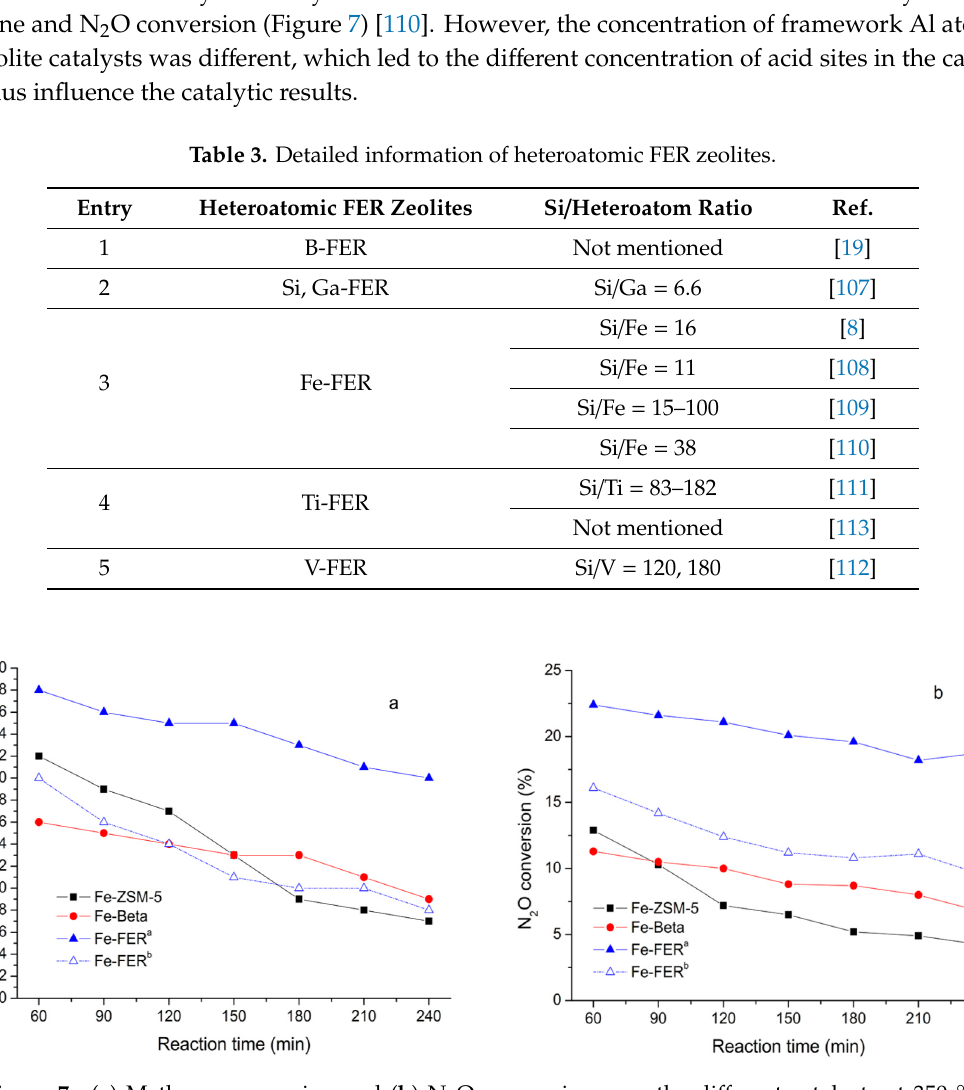
Figure 7. ( a ) Methane conversion and ( b ) N 2 O conversion over the di ff erent catalysts at 350 ◦ C (Fe-ZSM-5, Fe-Beta, Fe-FER a , 200 mg of catalysts; Fe-FER b , 100 mg of catalyst). Reprinted with permission from ref. [110]. Copyright 2019, American Chemical Society.